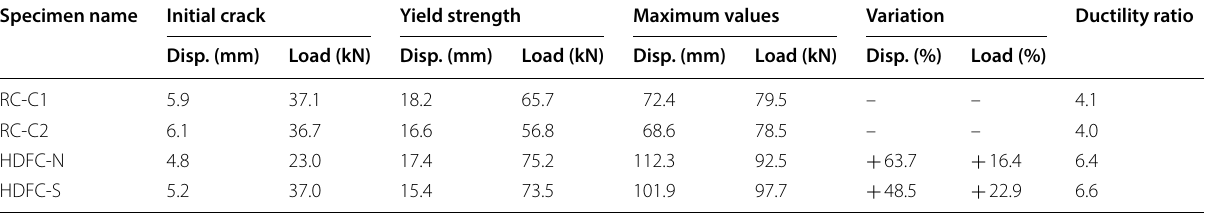
Table 3 Test results for each